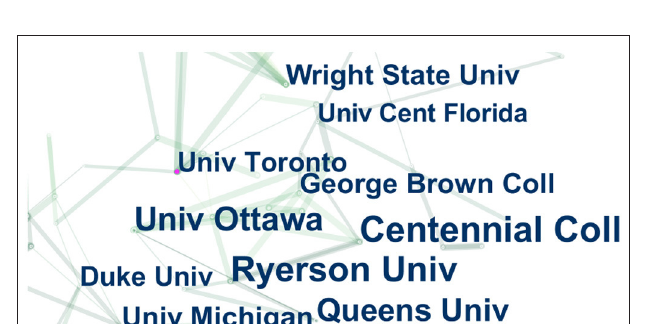
FIGURE 4 | The cooperation of countries or regions that contributed to publications on applying VR to the study of nursing from 2012 to 2021. The number of documents sent by the country is represented by the size of the green node. Countries’ cooperation is represented by connecting lines. The purple ring area size indicates the influence of the regional articles, which is equal to centrality.